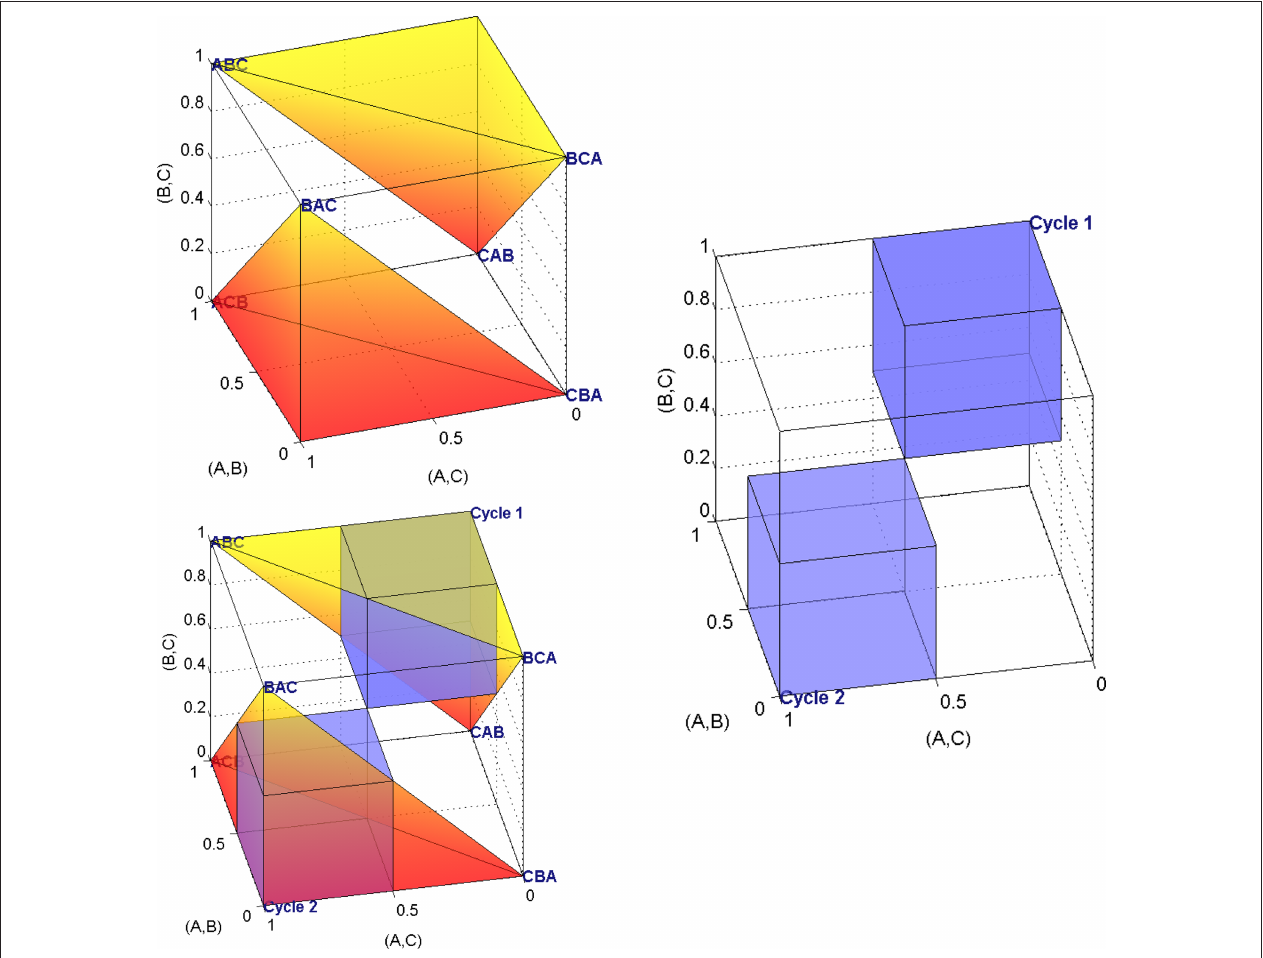
Figure 1 | upper left: The unshaded volume is the linear ordering polytope for m = 3. Upper right: The unshaded volume is weak stochastic transitivity for m = 3. Lower left: Both conditions shown together for comparison. Writing top is P , and the remaining axis, from right to left, is P bc